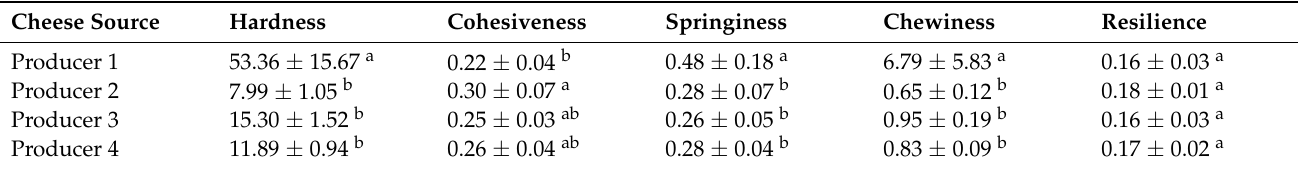
Table 3. Results of texture analysis of Queijo de Estrella PDO